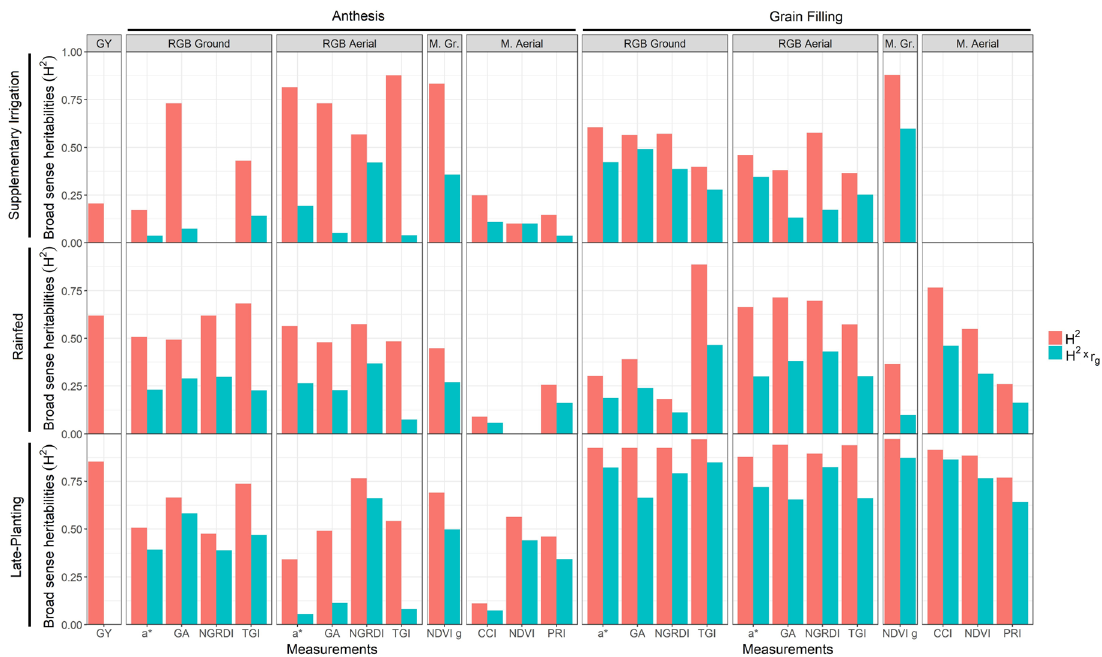
Figure 5. Bar graph comparison of the grain yield and the H 2 (orange) and H 2 × r g (blue) indexes of a selection of indexes.